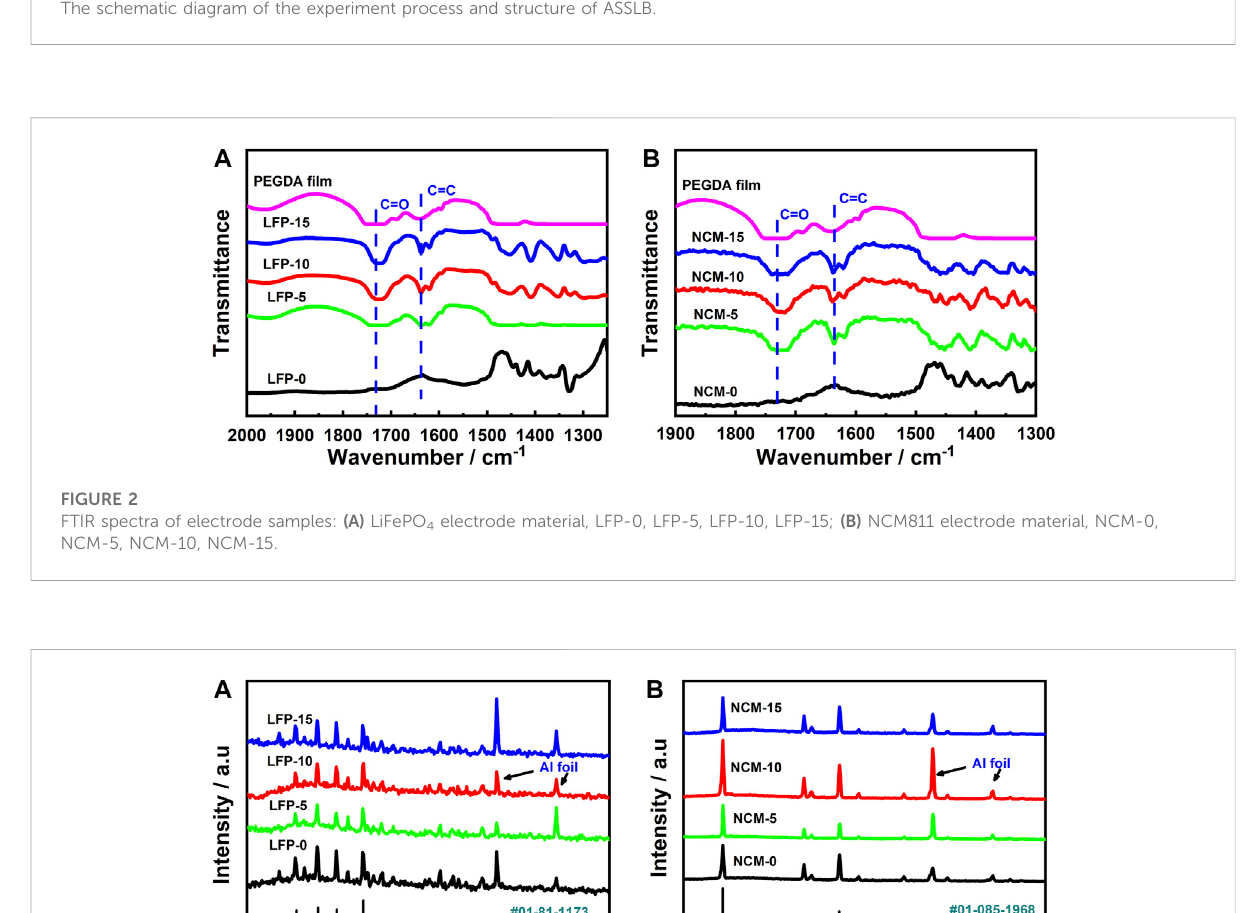
The schematic diagram of the experiment process and structure of ASSLB.